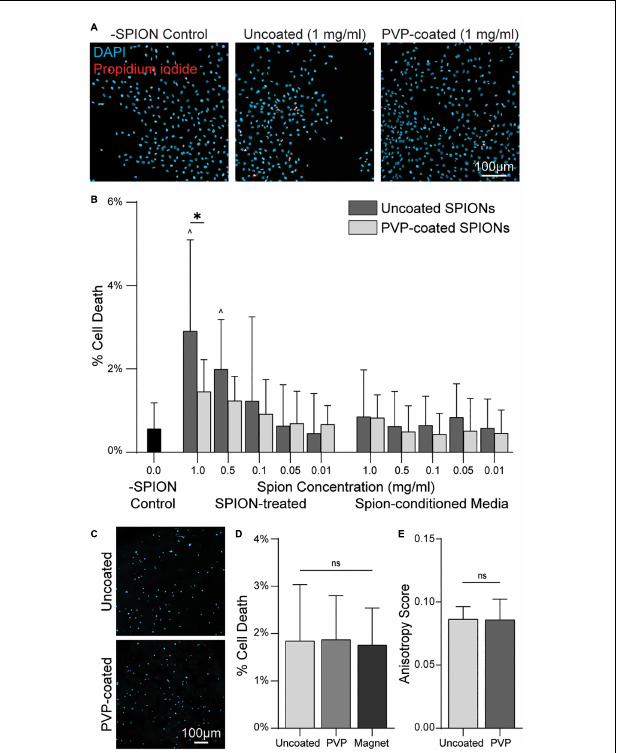
FIGURE 5 | PVP-coated SPIONs improve cytocompatibility without compromising magnetic alignment. (A) Hoechst and propidium iodide (PI) staining of MCF10As with uncoated or PVP-coated SPIONs added to culture media for 12 h. (B) Quantification of MCF10A death as measured by % PI + nuclei with either SPIONs directly added to media (SPION-treated) or SPIONs incubated in media and then removed prior to media transfer to cells (SPION-conditioned Media). (C) Hoechst/PI staining of single MCF10As encapsulated alongside SPION fibers in DVS hydrogels after 12 h of culture. Non-fibrous gel exposed to a magnetic field (Magnet). (D) Corresponding quantification of % cell death. (E) Alignment of fibers containing SPIONs with or without PVP coating. All data presented as mean ± SD; ∗ indicates a statistically significant comparison with p < 0.05; ˆ indicates significance against no SPION